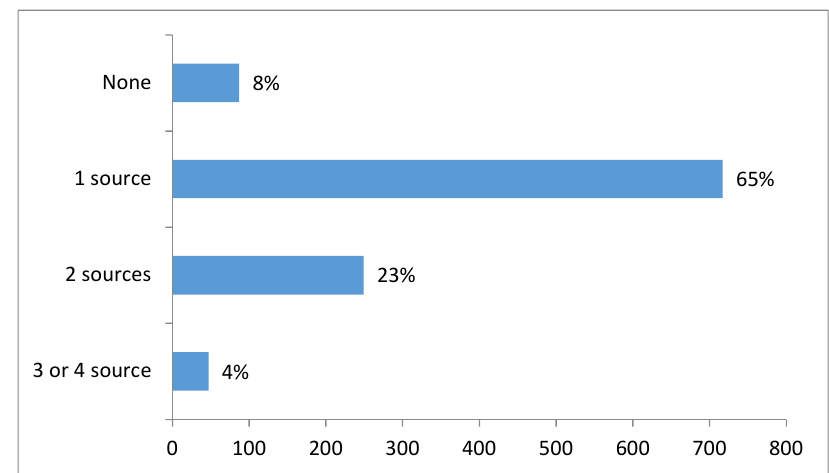
Figure 4. Number of sources from which participants received information about NBS.